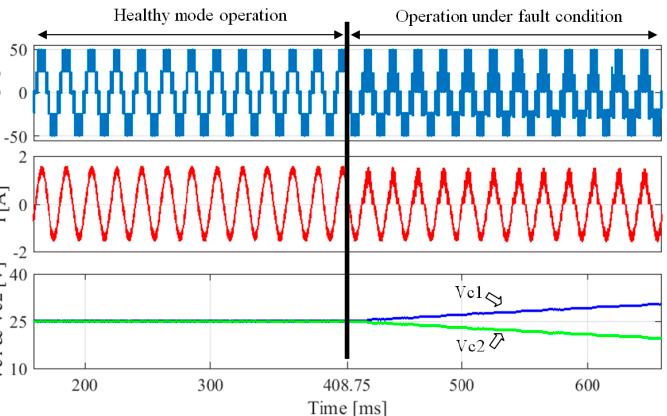
Figure 3. Simulation results of the inverter operation under open-circuit fault occurrence in D C4 , without fault-tolerant strategy.